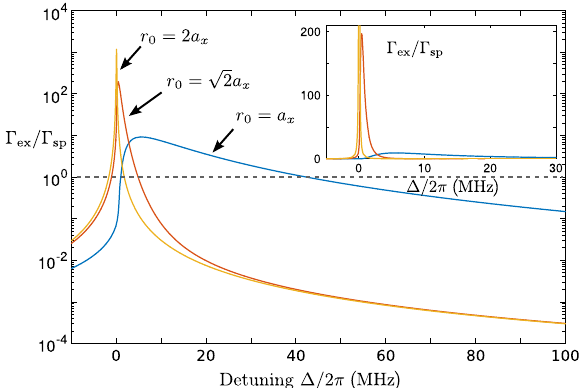
= Γ for three different interparticle ex sp 2 a already 0 ¼ x